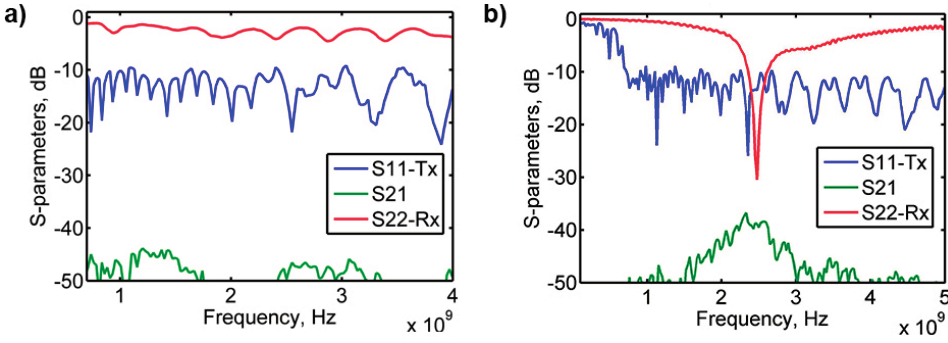
Figure 10. Typical results of the gain measurements for the LCX ( a ) and dipole ( b ) textile integrated fiber antennas. The S11 curves (blue) correspond to the return losses of the Aaronia HyperLog 7060 antenna and S 22 curve (red) to the return losses of the antenna under study, the green S 21 curve represents the power transmitted from one antenna to another over the 150 cm distance in unobstructed lab environment. Antenna gains were measured to be 1.62 dBi for the LCX antenna, and at 3.34 dBi for the dipole